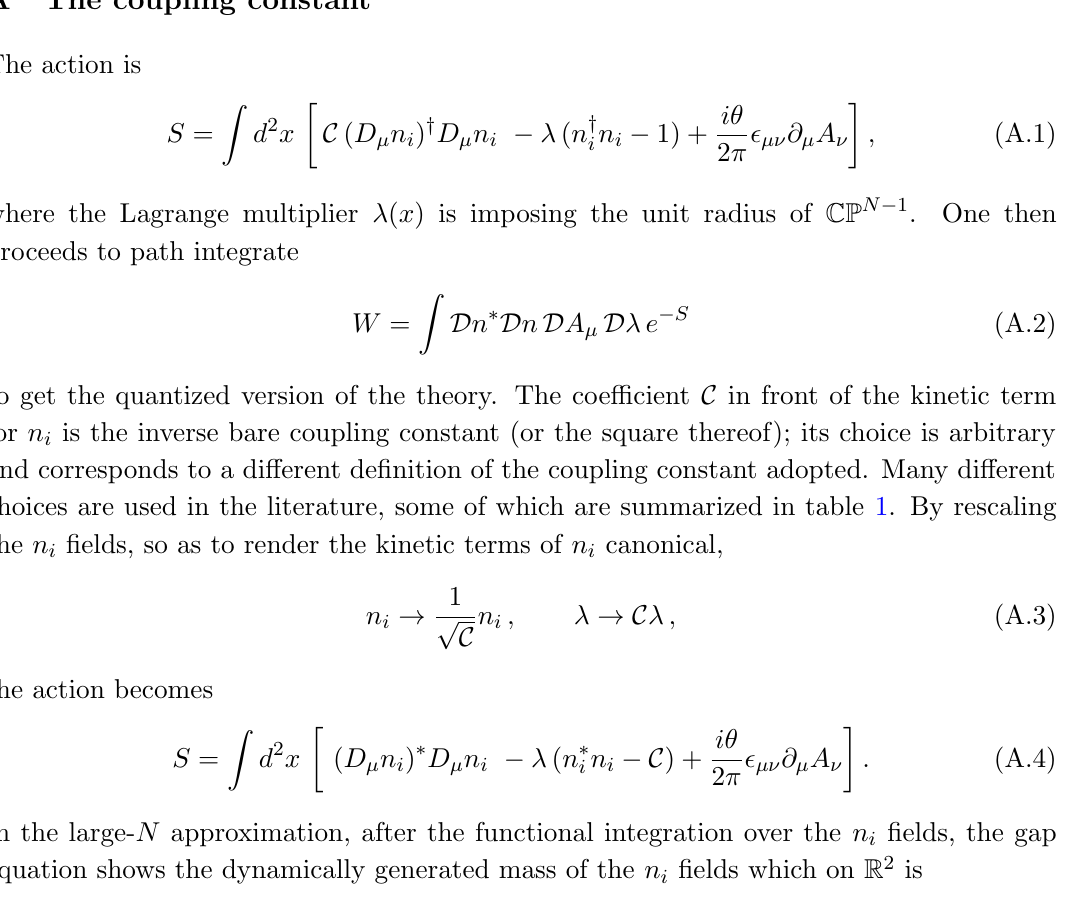
Table 1 . Di(cid:11)erent de(cid:12)nitions of the coupling constant used in the literature. A The coupling